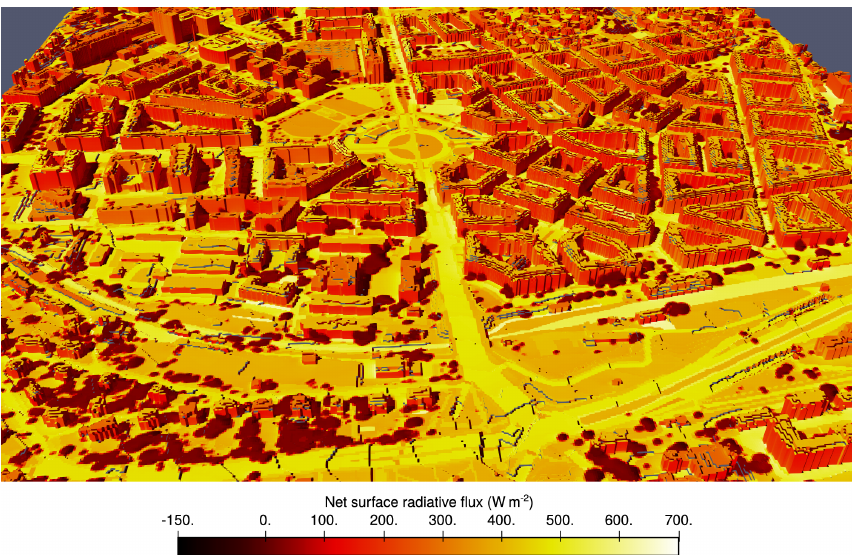
Figure 11. A 3-D representation of instantaneous net SW + LW radiative fluxes in a large urban scenario. A north-oriented view of the inner domain of the Prague–Dejvice validation